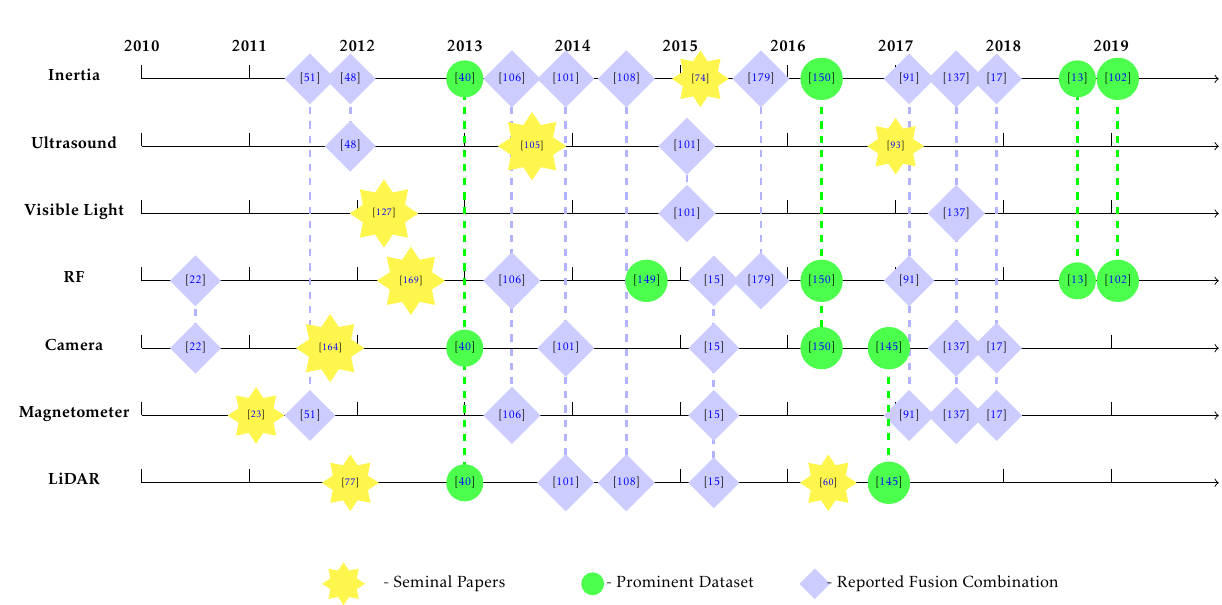
Figure 6. Outline of reported fusion combinations, data sets and seminal papers in the literature of sensors and their fusion for indoor localisation in the past decade. The data sets and fusion combinations include dashed lines, signifying that the study encompassed respective selected